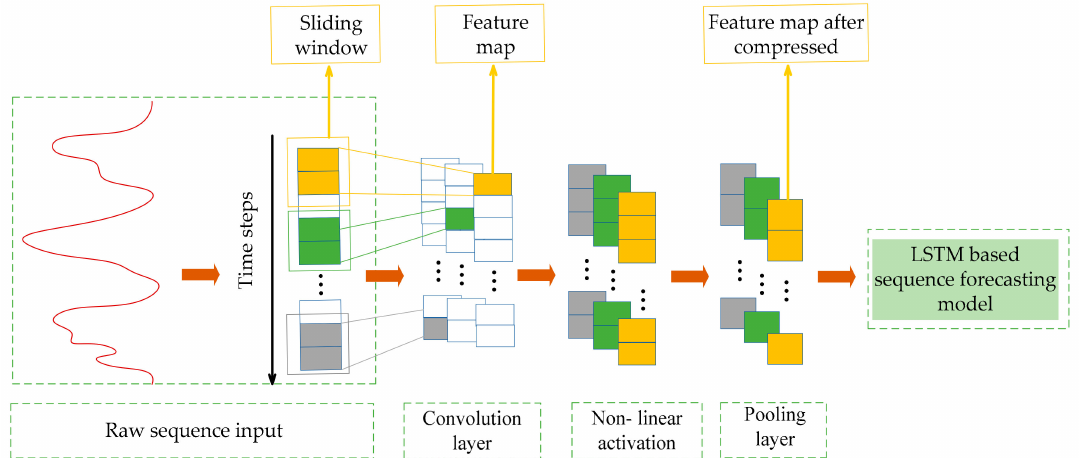
Figure 4. The picture shows the framework of the CNN based local feature extractor. The convolution layer consists of different filters marked by yellow, green and grey colors. Each filter can generate a specific feature map to extract the key information of the raw sequence input through sliding the corresponding windows. The activation function is used to enhance the ability of models to learn more complex functions. The function of pooling is equal to subsampling as it subsamples the output of convolutional layer based on the definite pooling